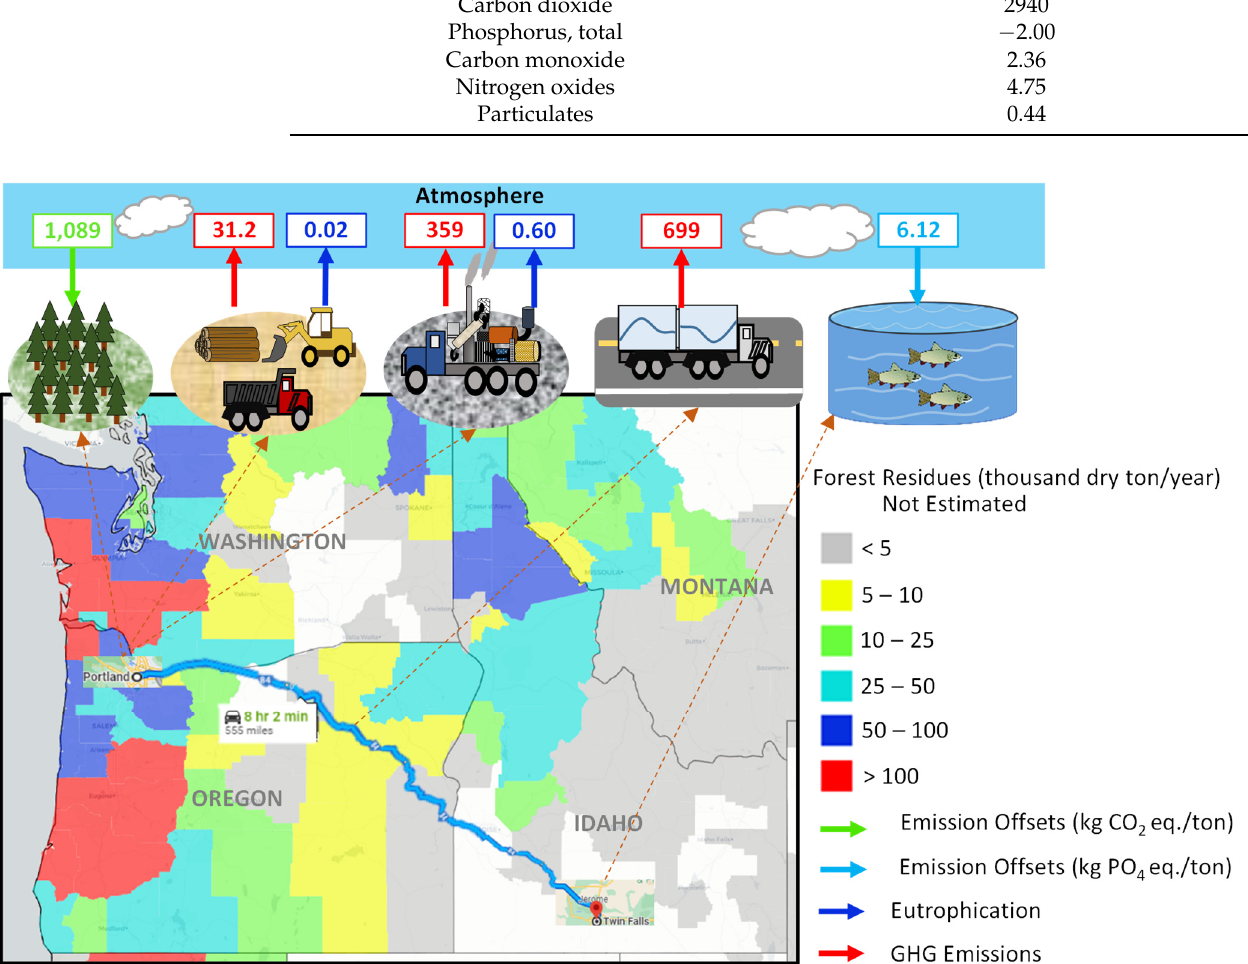
Figure 7. Schematic of emissions cycle, using biomaterials for phosphorus and nitrogen adsorption from downstream fish farm waters, maps from NREL Biofuels Atlas (public domain) [44].